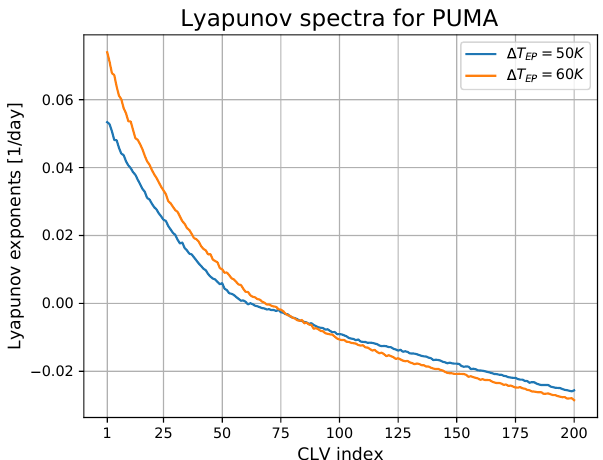
Figure 1. The 200 largest LEs of the Lyapunov spectra of PUMA for the two different set-ups with (cid:49)T EP = 50 and 60K. For (cid:49)T EP = 50K, the number of positive Lyapunov exponents is 61 and D KY = 172 . 6. For (cid:49)T EP = 60K, the number of positive Lyapunov expo- nents is 68 and D KY = 187 .